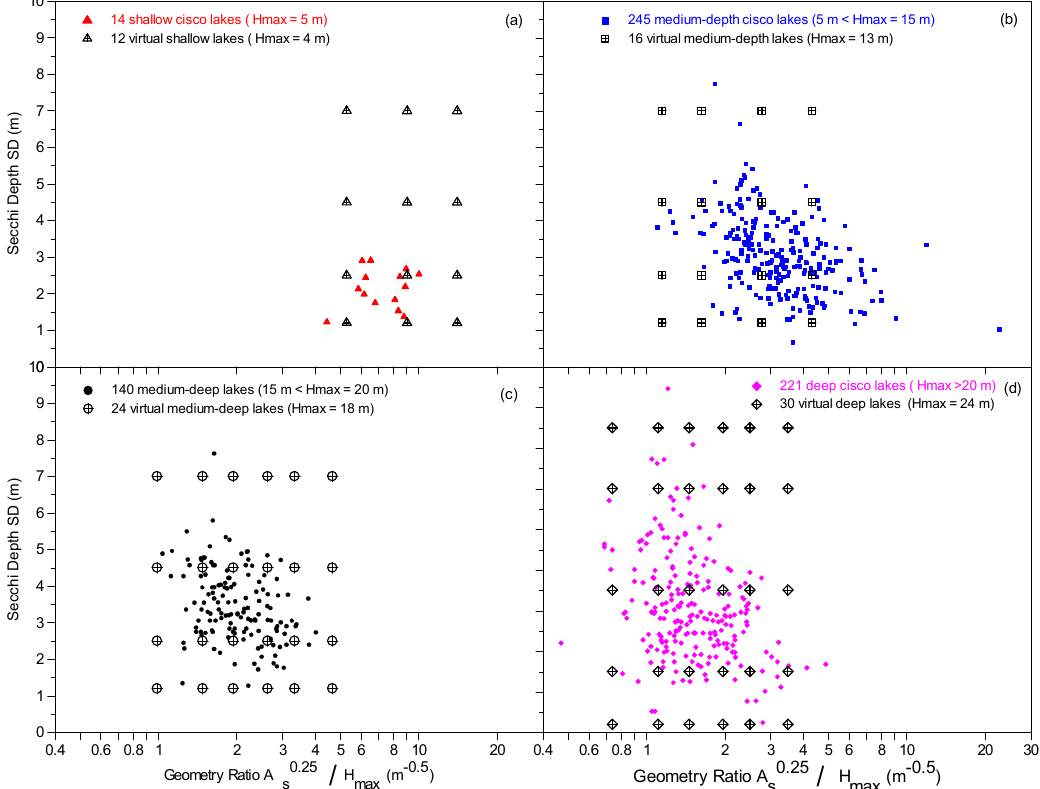
Figure 6. Distribution of: ( a ) 14 shallow-depth lakes; ( b ) 245 medium-depth lakes; ( c ) 140 medium-deep lakes; and ( c ) 221 deep lakes of 620 cisco lakes in Minnesota including: ( a ) 12 shallow virtual lakes; ( b ) 16 medium-depth virtual lakes; ( c ) 24 medium-deep virtual lakes; and ( d ) 30 deep virtual lakes plotted using Secchi depth and lake geometry ratio as independent variables.